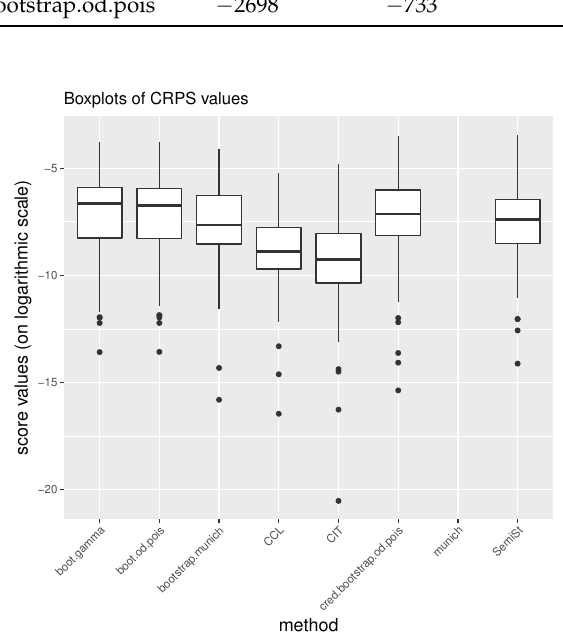
Figure 5. Boxplots of CRPS values from the private passenger auto liability